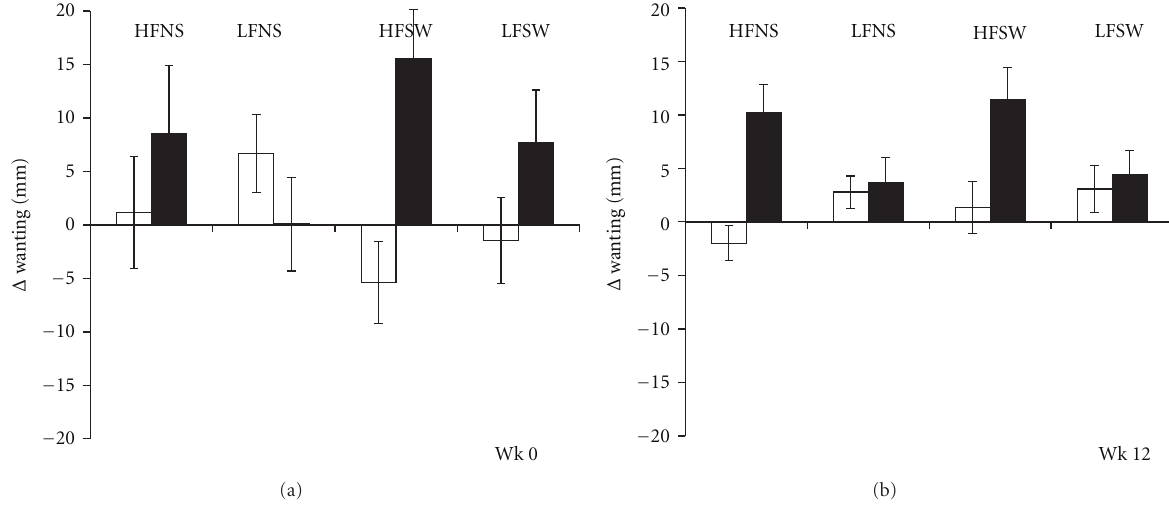
Figure 3: Acute changes in explicit wanting for food categories measured before and after a single bout of exercise in Responders ( (cid:2) ) and Nonresponders ( (cid:3) ). HF: high fat, LF: low fat, NS: non-sweet, SW: